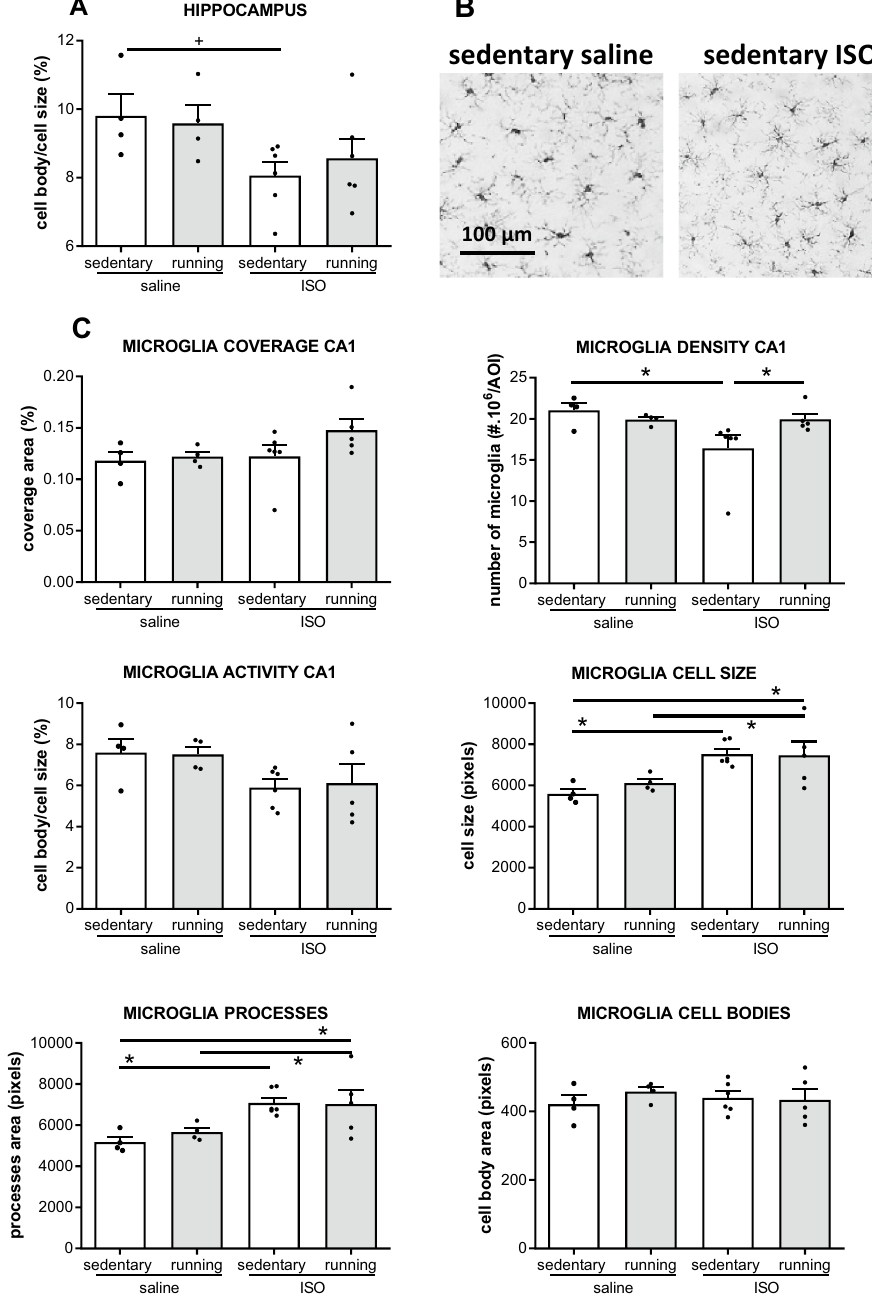
Figure 3. Microglia activity in the hippocampus, in saline or isoproterenol (ISO) treated rats, under sedentary conditions or after five weeks of exercise training, (n = 4, 4, 6, 6 for saline sedentary, saline exercise, ISO sedentary and ISO exercise rats, respectively). ( A ): Overall microglia activity in the hippocampus; ( B ): typical pictures of microglia in the CA1 in saline sedentary and ISO sedentary rats (tile size: 0.1mm 2 ); ( C ): Morphological parameters underlying the calculated microglia activity in the CA1 area, as the area best reflecting overall effects on the hippocampus. + : tendency (ANOVA p < 0.10; subsequent post-hoc test <